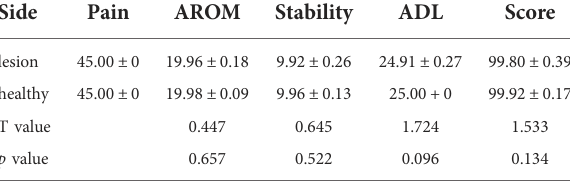
AROM, active range of motion; ADL, activities of daily